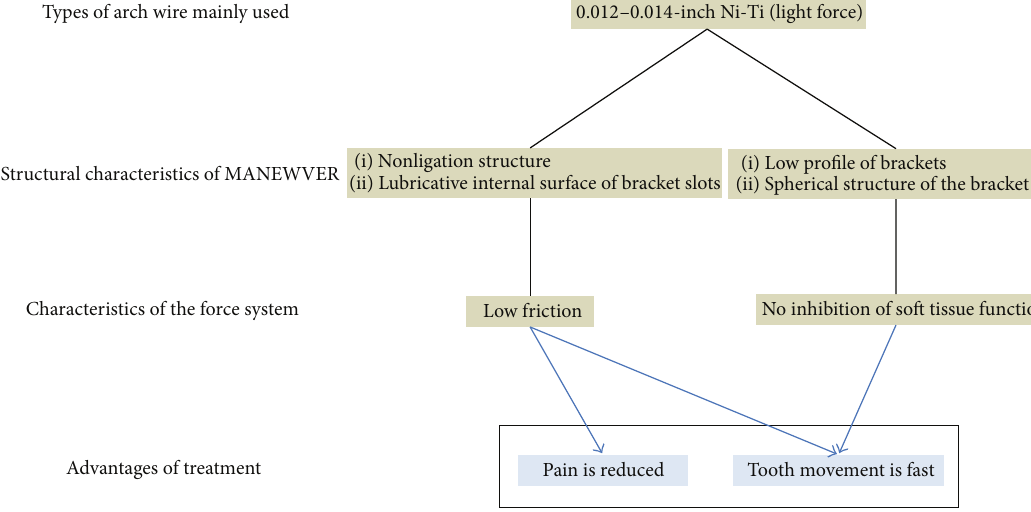
Figure 8: Properties of the new orthodontic treatment